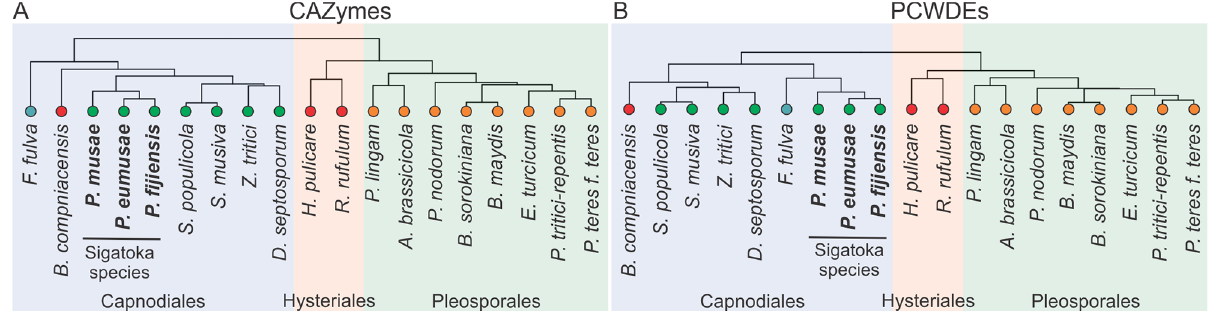
Fig 7. Hierarchical clustering of Pseudocercospora musae , Pseudocercospora eumusae , Pseudocercospora fijiensis , and 16 other representative Dothideomycete fungi with different nutritional lifestyles, based on copy number changes in carbohydrate- active enzyme (CAZyme) families or the subset of plant cell wall degrading enzymes (PCWDEs). The selected 16 representative Dothideomycete species that are included in the analysis fall into three major orders: Capnodiales (red), Hysteriales (blue), and Pleosporales (green). The nutritional lifestyle of each species is indicated by a colored dot next to each species name: biotrophs (blue), hemi-biotrophs (green), necrotrophs (yellow), saprophytes (red). (A) Hierarchical clustering of the species based on their total CAzyme distribution profile (i.e. the number of genes assigned to each CAZyme family) (B) Hierarchical clustering of the species based on their distribution profile for CAZyme families related to plant cell wall degradation. In both cases, clustering supported a swapped topology in which P . eumusae is clustered together with P . fijiensis , suggesting that these two species share a more similar pattern of gene family expansions and contractions in CAZymes and PCWDEs in